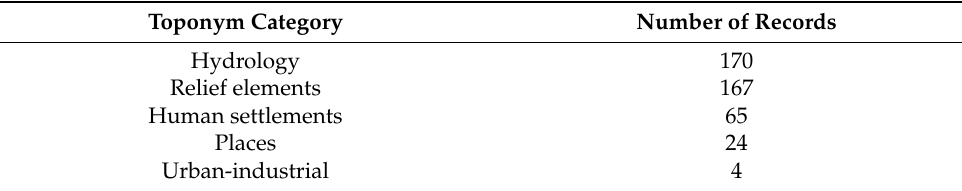
Table 3. Toponym category and number of records, Sierra de San Miguelito, San Luis Potosi. Toponym